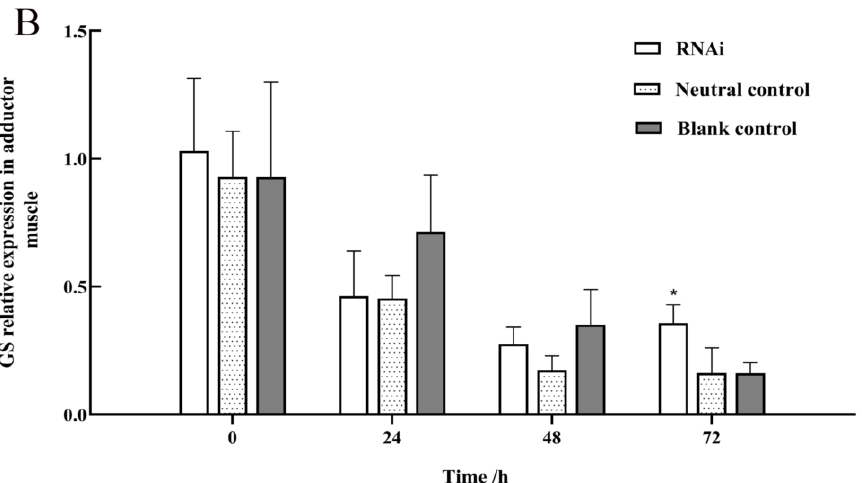
Figure 6. GSK3β ( A ) and GYS ( B ) expression after dsRNA injection in adductor muscle (n = 3). The asterisk indicates significant difference ( p < 0.05) between RNAi and neutral control group. The double asterisks indicates highly significant difference between RNAi and neutral controls ( p < 0.01).